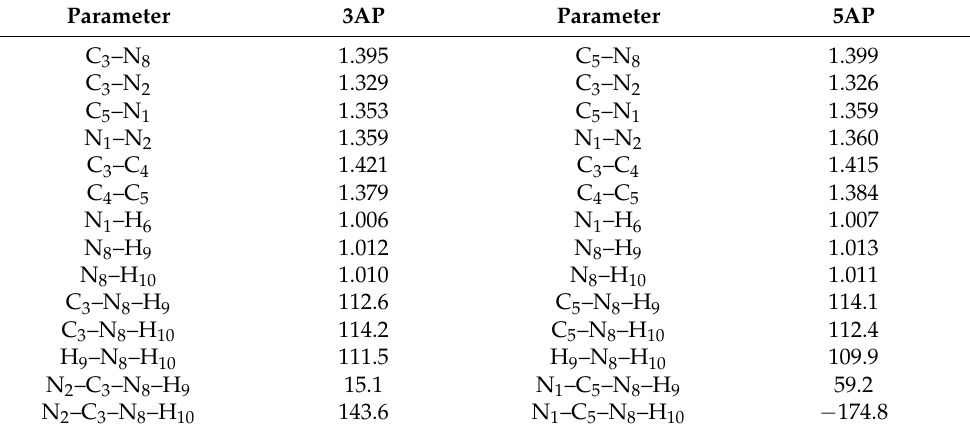
Table 1. B3LYP(6-311++G(d,p) calculated selected relevant structural parameters for 3AP and 5AP a